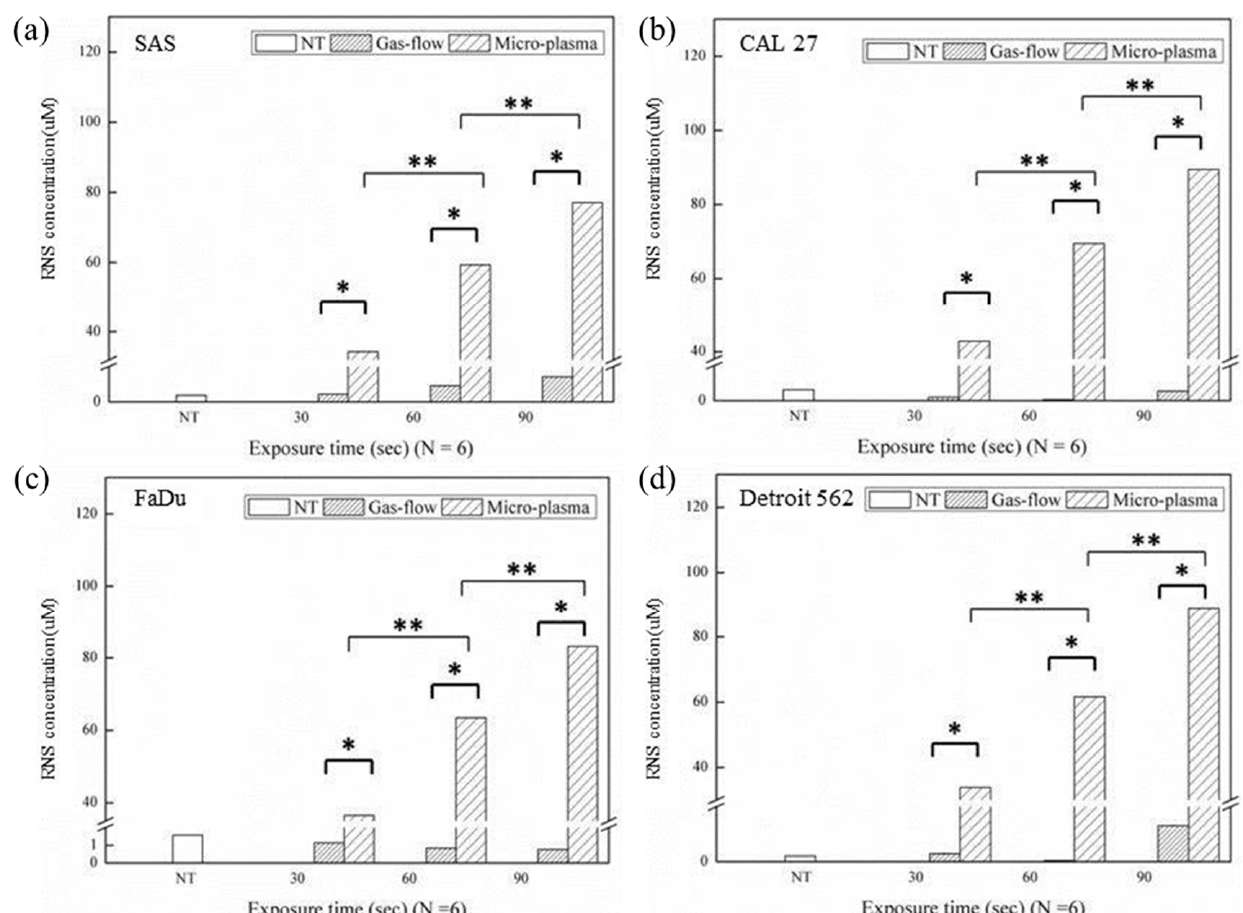
Figure 2. RNS content in the stimulated medium with ( a ) SAS, ( b ) CAL 27, ( c ) FaDu, or ( d ) Detroit 562 after plasma exposure and gas flow for a similar duration and then cultured for 48 h. The medium without cells and the medium with cells and gas flow for a similar duration were taken as the references. The values of p < 0.05 (*) and p < 0.01 (**) were considered statistically significant.